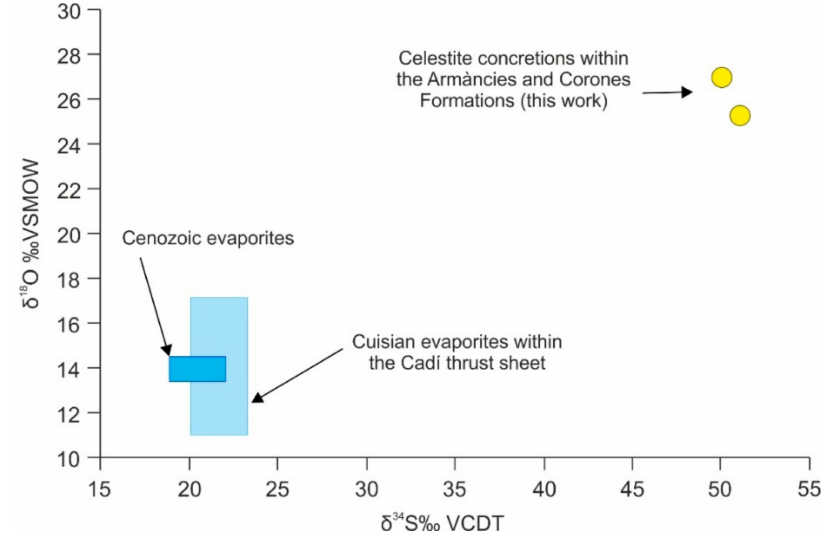
Figure 13. δ 34 S and δ 18 O of celestite concretions within the Corones and Arm à ncies Formations. Values for Cenozoic evaporites from Reference [66] and for evaporites in the Cad í thrust sheet from Reference [97] are also